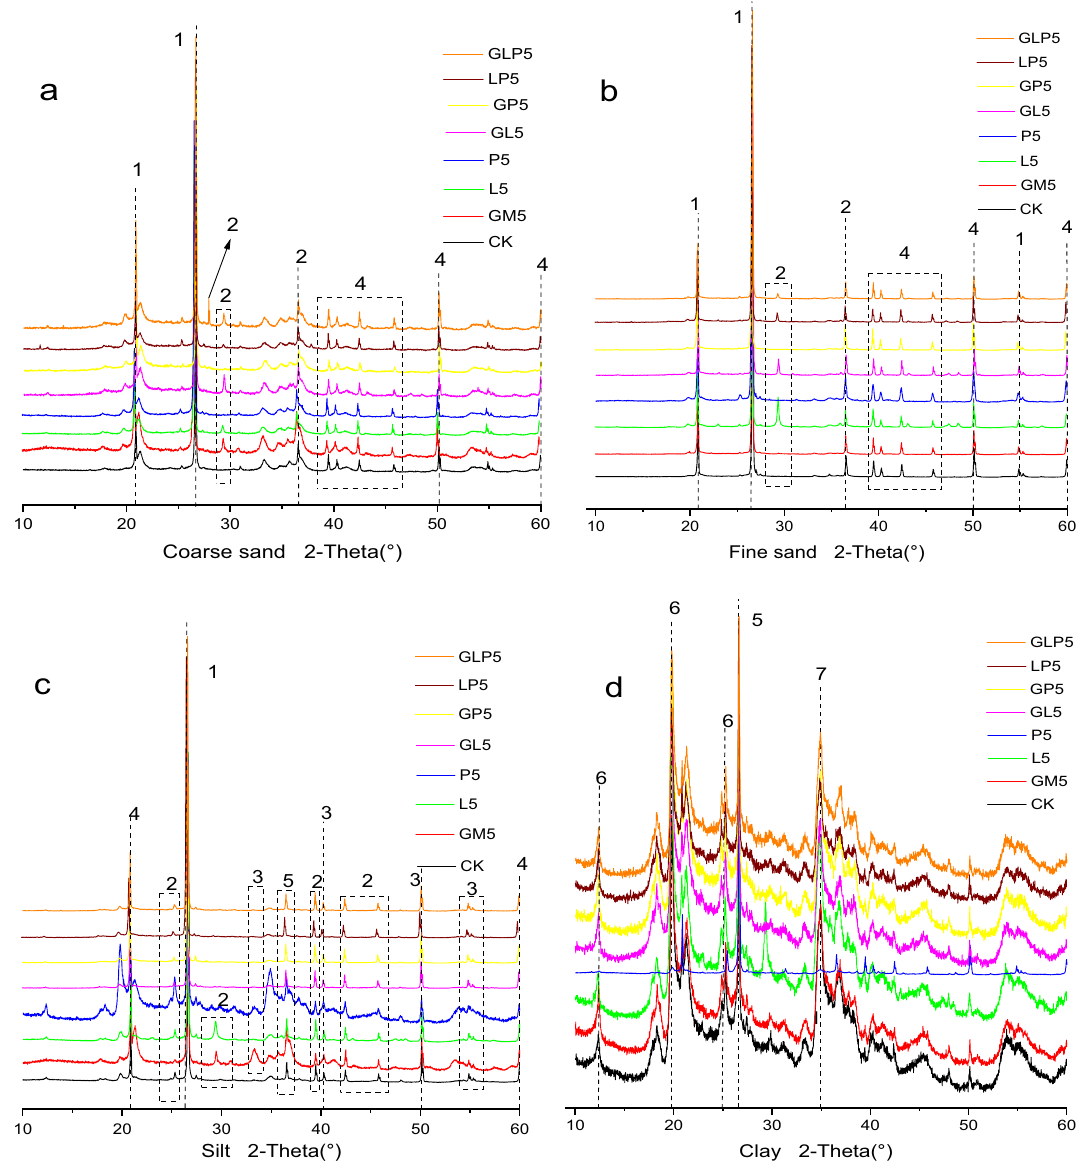
Figure 8. XRD patterns of coarse sand, fine sand, silt, and clay soil particles after passivator treatments. (1: quart, 2: feldspar, 3: mica, 4: zeolite, 5: illite, 6: chlorite, 7: calcite) (Origin 2019b). (CK: control check, GM: goat manure, L: Ca(OH) 2 , P: Ca(H 2 PO 4 )·2H 2 O, GL: goat manure + Ca(OH) 2 , GP: goat manure + Ca(H 2 PO 4 )·2H 2 O, LP: